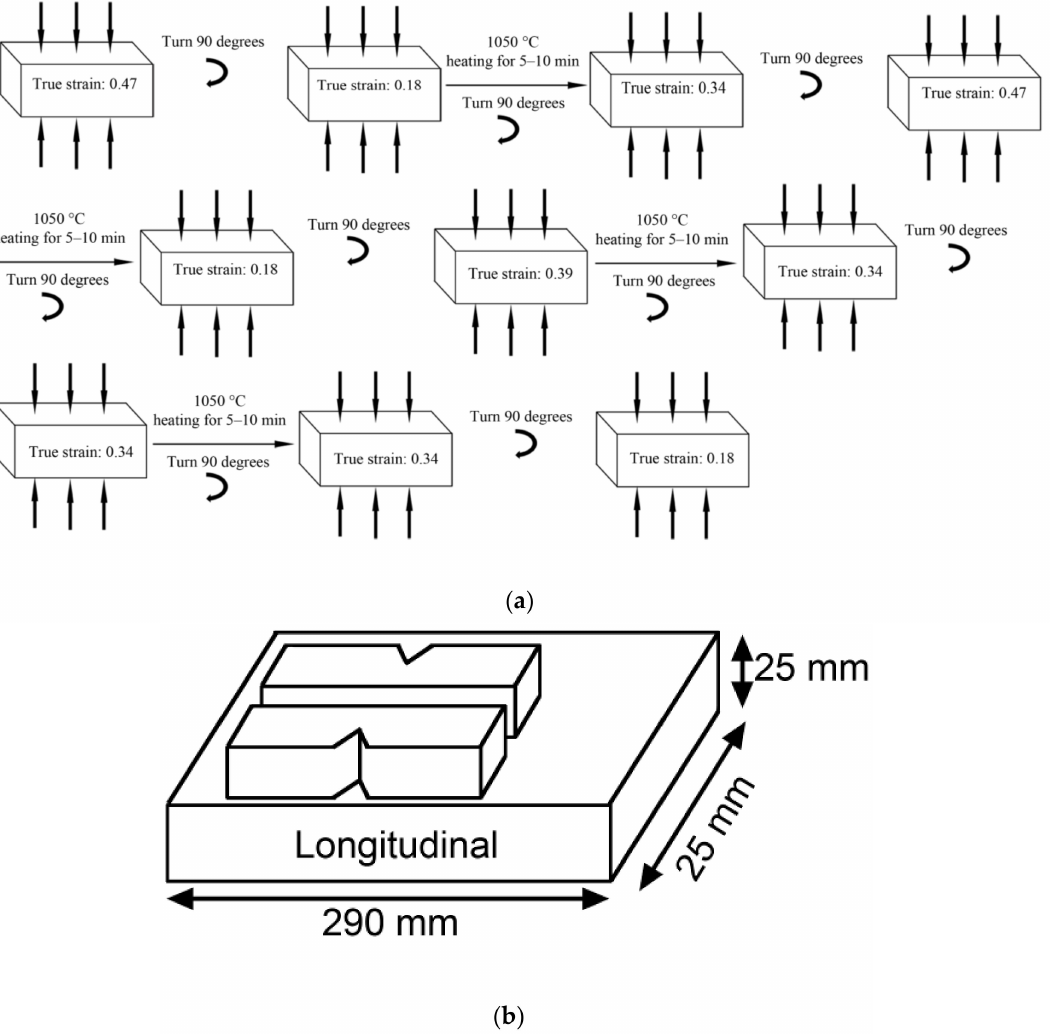
Figure 2. ( a ) Schematic illustration of a forging operation at 1050 ◦ C with a true strain of ~3; ( b ) the location of Charpy V-notch samples in the forged